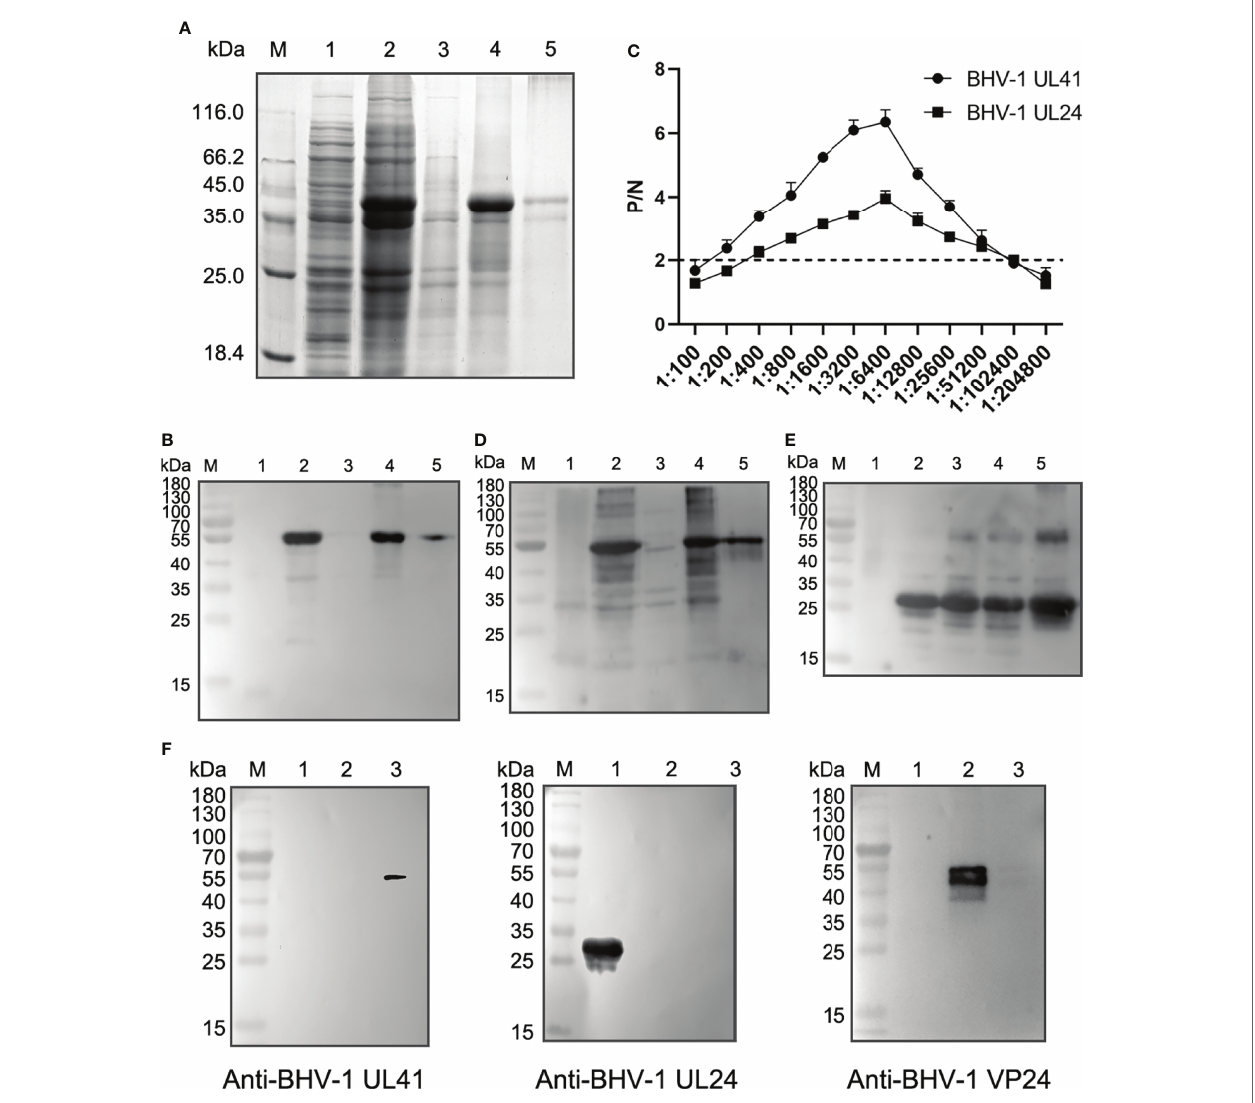
FIGURE 2 | Detection sensitivity and speci fi city of rabbit anti-BHV-1 UL41 antibodies. (A) Expression analysis of rHis-BHV-1 UL41. Lane M: protein molecular ladder; lane 1: negative control of the pET30a(+) vector; lane 2: rHis-BHV-1 UL41 after induction; lane 3: supernatants of rHis-BHV-1 UL41; lane 4: sedimentations of rHis-BHV-1 UL41; lane 5: puri fi ed rHis-BHV-1 UL41. (B) Western blot analysis of rHis-BHV-1 UL41 expression. Notes of the lanes are the same as panel (A) . A mouse anti-His monoclonal antibody was used as the primary antibody. (C) ELISA of rabbit anti-rHis-BHV-1 UL41 and rabbit anti-rHis-BHV-1 UL24 polyclonal antibodies. P/N indicates the positive value/negative value ratio. The horizontal axis indicates the serum dilution. The dotted line indicates a P/N value of 2, which was the criterion value. (D) Speci fi city analysis of a rabbit anti-rHis- BHV-1 UL41 polyclonal antibody. Notes of the lanes are the same as panel (A) .The prepared rabbit anti-BHV-1 UL41 polyclonal antibody was used as the primary antibody. (E) Speci fi city analysis of a rabbit anti-rHis-BHV-1 UL24 polyclonal antibody. Lane M: protein molecular ladder; lane 1: negative control of the pET30a(+) vector; lane 2: rHis- BHV-1 UL24 after induction; lane 3: supernatants of rHis-BHV-1 UL24; lane 4: sedimentations of rHis-BHV-1 UL24; lane 5: puri fi ed rHis-BHV-1 UL24. The prepared rabbit anti-BHV-1 UL24 polyclonal antibody was used as the primary antibody. (F) Speci fi city analysis of the rabbit anti-rHis-BHV-1 polyclonal antibodies. Lane M: protein molecular ladder; lane 1: puri fi ed rHis-BHV-1 UL24; lane 2: puri fi ed rHis-BHV-1 VP24; lane 3: puri fi ed rHis-BHV-1 UL41. The primary antibody on the left is the rabbit anti-rHis-BHV-1 UL41 polyclonal antibody; that in the middle is the rabbit anti-rHis-BHV-1 UL24 polyclonal antibody; and that on the right is the rabbit anti-rHis-BHV-1 VP24 polyclonal